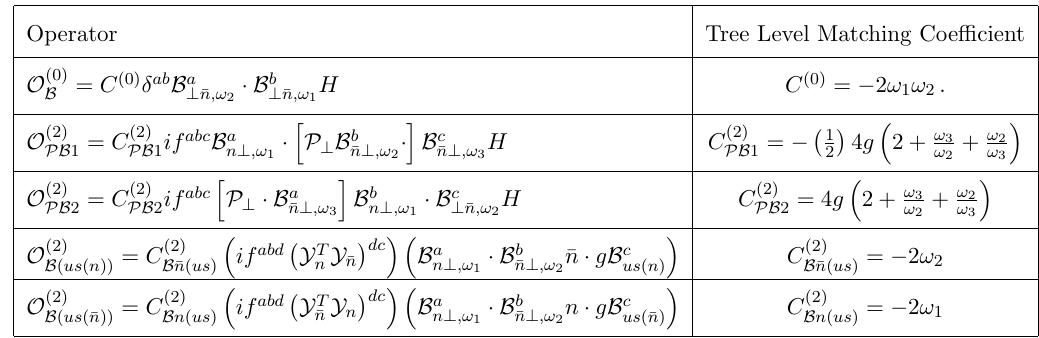
Table 1 . Hard scattering operators that contribute to the LL cross section to O ( (cid:21) 2 ), along with their tree level matching coe(cid:14)cients. These operators and matching coe(cid:14)cients were derived in